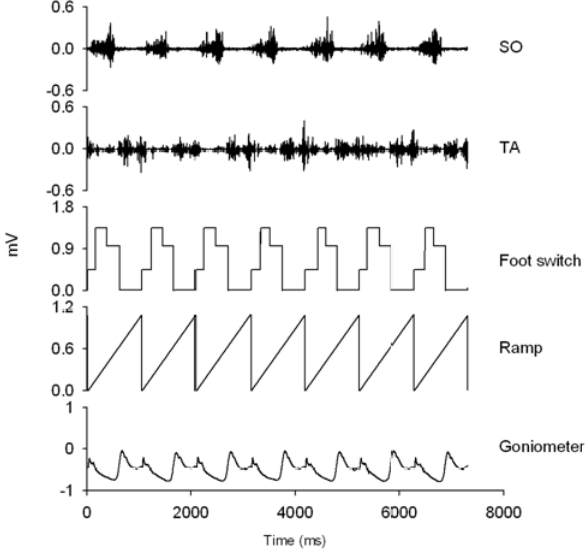
Figure 1. Representative experimental recordings. From top: 1) Raw EMG recordings of SO, TA, 2) foot switch signal, 3) ramp function, which was reset at heel strike, 3) goniometer signal showing the ankle joint angle. All signals are raw and expressed in